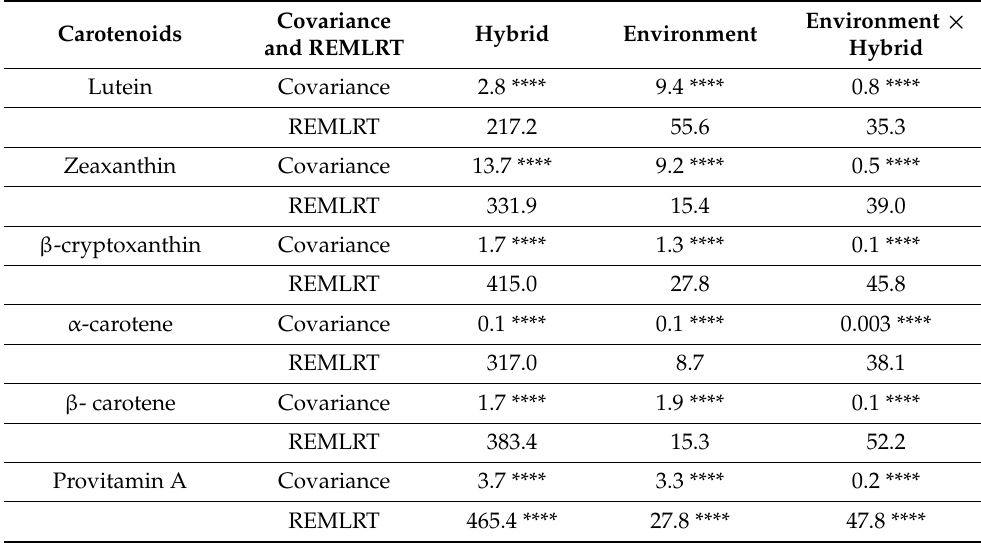
Table 1. Covariance estimates and their significant test for carotenoids, including provitamin A, through the residual maximum likelihood ratio test (REMLRT) based on the combined analyses of trials involving 64 hybrids evaluated across 23 environments.